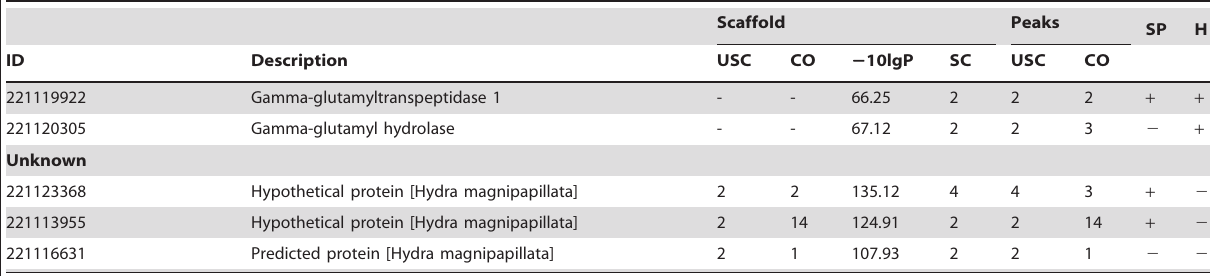
Protein identifications using Mascot and PEAKS. Abbreviations used: ID — identification number corresponding to custom database supplied as S5; USC — number of unique and significant spectra contributing to the identification; SC — total number of significant spectra contributing to the identification; CO — percent cover; and 2 10lgP — the PEAKS probability based score. A ‘ + ’ in the SP column denotes the presence of a signal sequence and a ‘ + ’ in the ‘H’ column denotes the identification of a similar protein in the H. magnipapillata venom proteome.